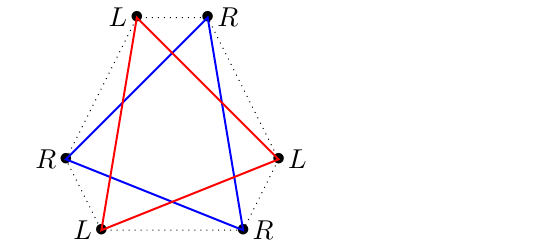
Figure 17. C [(1 ; 1)] brane with non-maximal regular zero modes. (a) Brane background together with a con(cid:12)guration involving ’ (cid:6) . (b) Brane background together with a con(cid:12)guration consisting i of (cid:27) (cid:6) . i